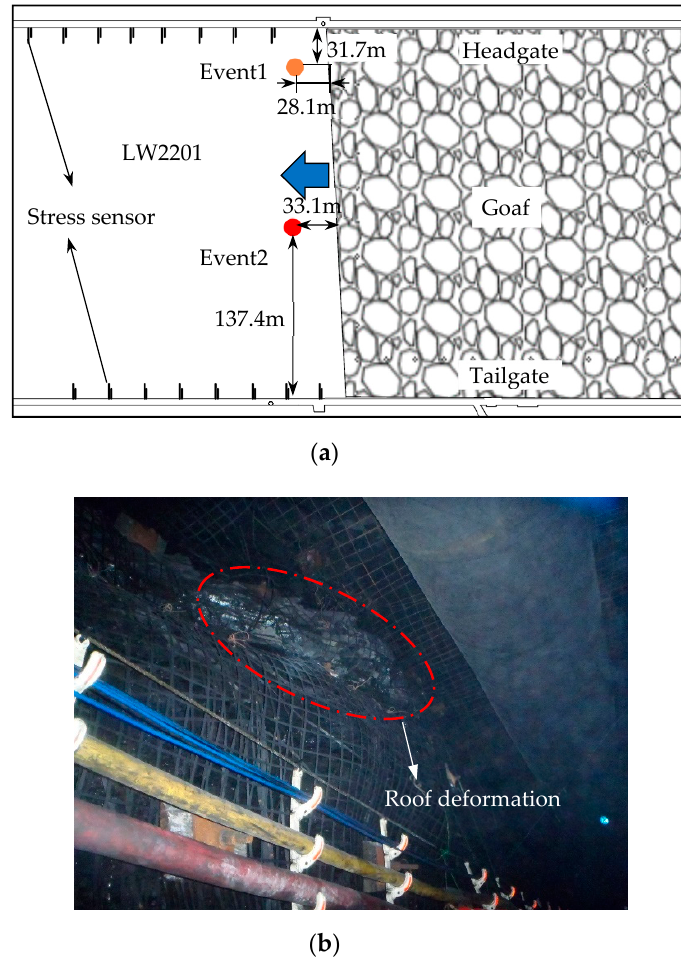
Figure 5. ( a ) Plane projection drawing of the two MS events. ( b ) Roof deformation of the roadway.